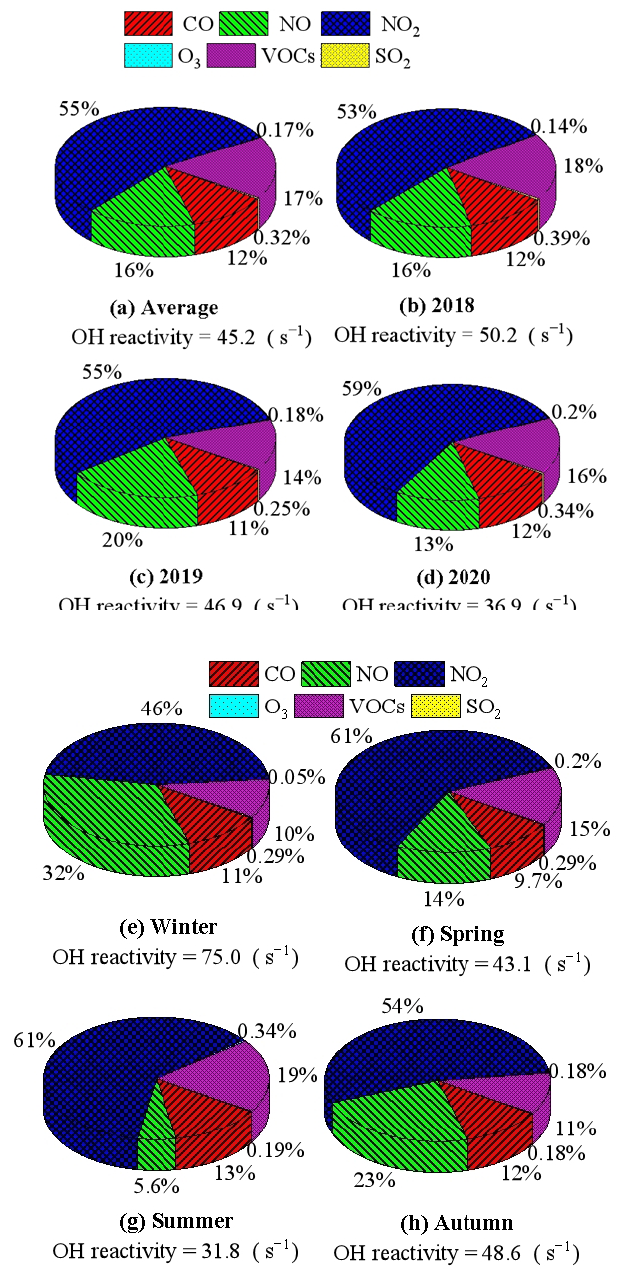
Figure 9. Comparison of the relative contributions of the OH reac- tivity in